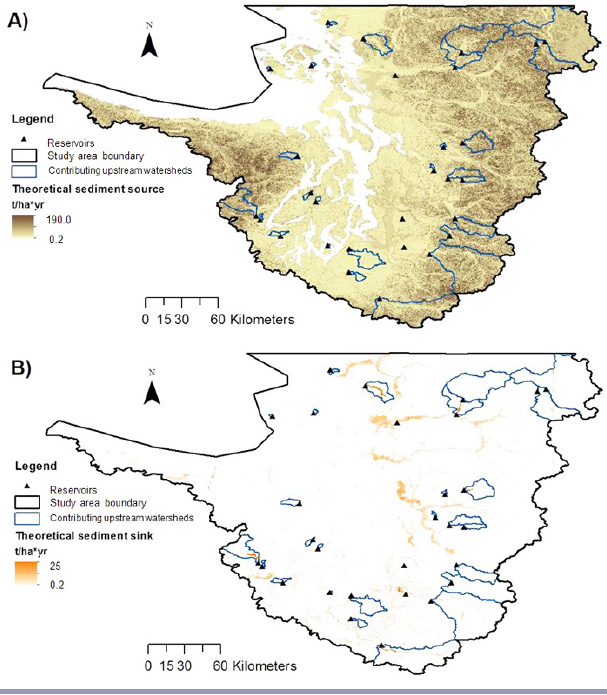
Fig. 7 . Theoretical and actual (a) sources and (b) sinks for erosion and sediment deposition in the Puget Sound Basin. Actual sources and sinks are limited exclusively to sub- watersheds upstream of